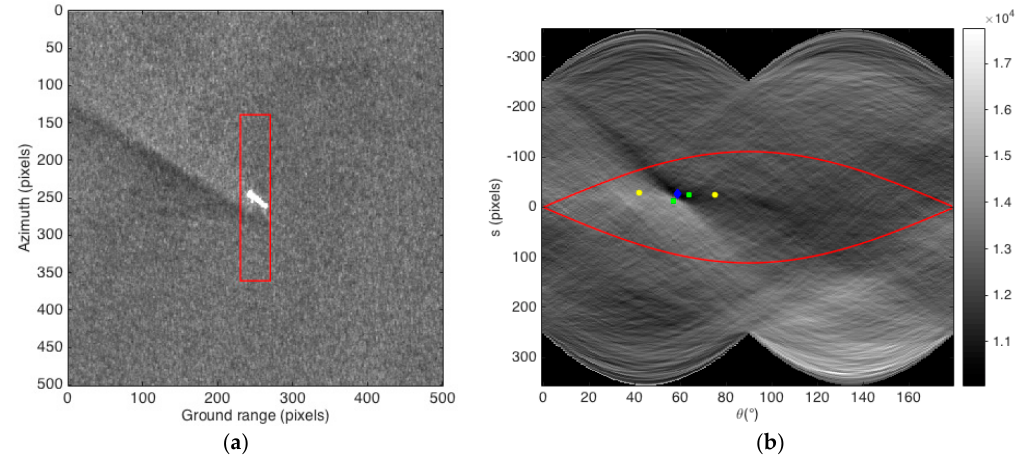
Figure 5. ( a ) Masked tile. The red rectangle is the mask covering the ship and propeller wake returns; ( b ) Detected wake features in the Radon domain. Two red sinusoidal curves define the restricted Radon domain. The blue diamond is the turbulent wake, the green squares are the narrow-V wakes, and the yellow dots are the Kelvin arms.